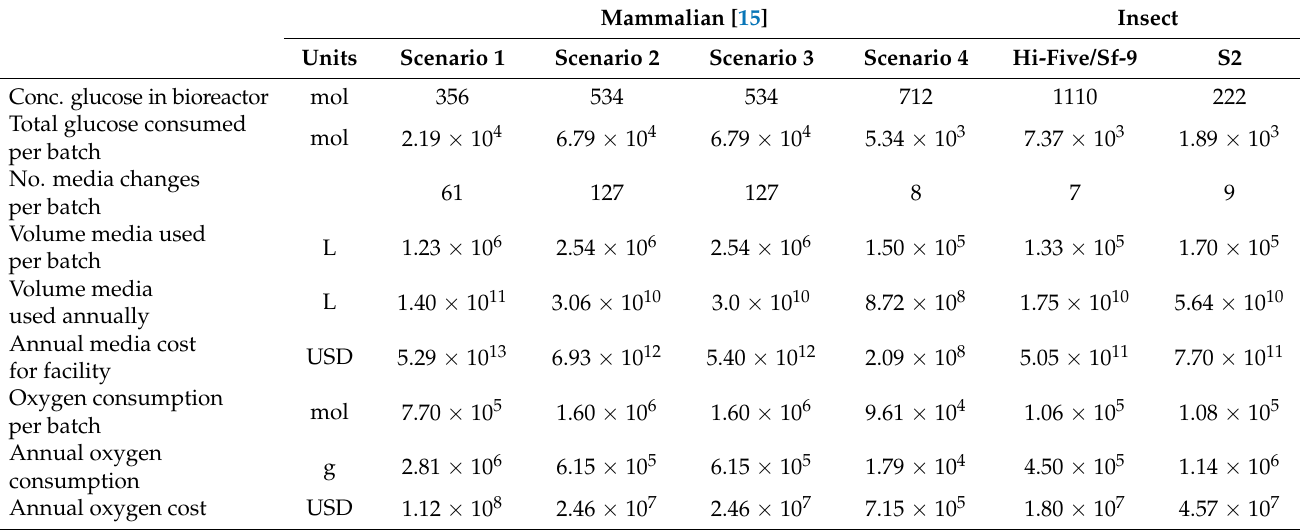
Table 4. Outcome values relating to media produced by the model for four mammalian scenarios proposed in the Risner et al. paper compared to outcomes for Hi-Five/Sf-9 and S2 insect cells